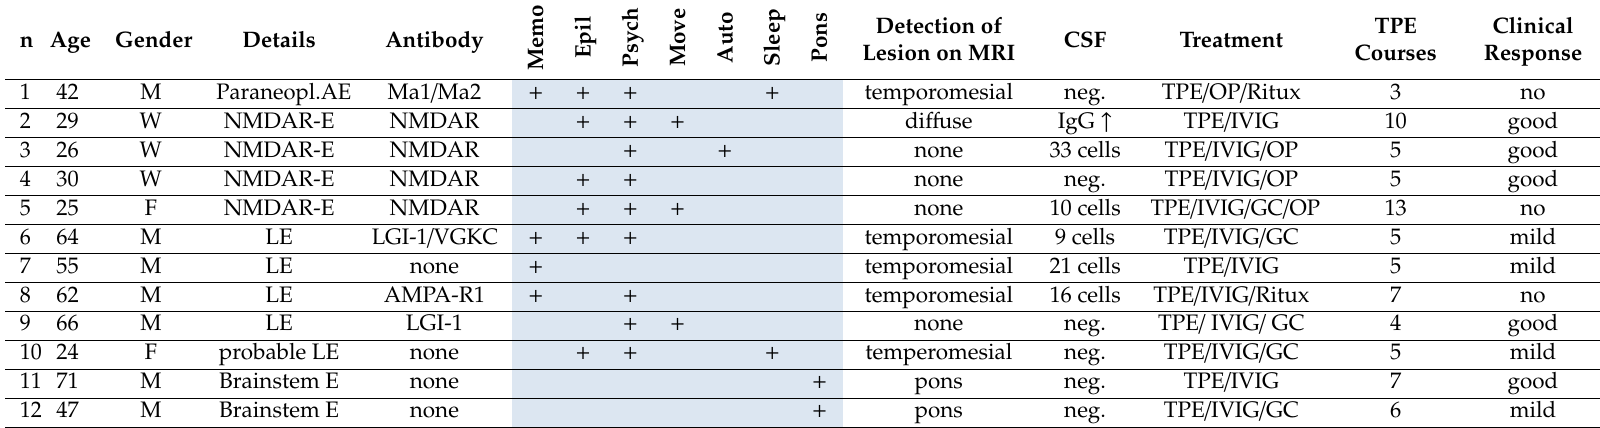
Table 2. TPE in patients with autoimmune encephalitis